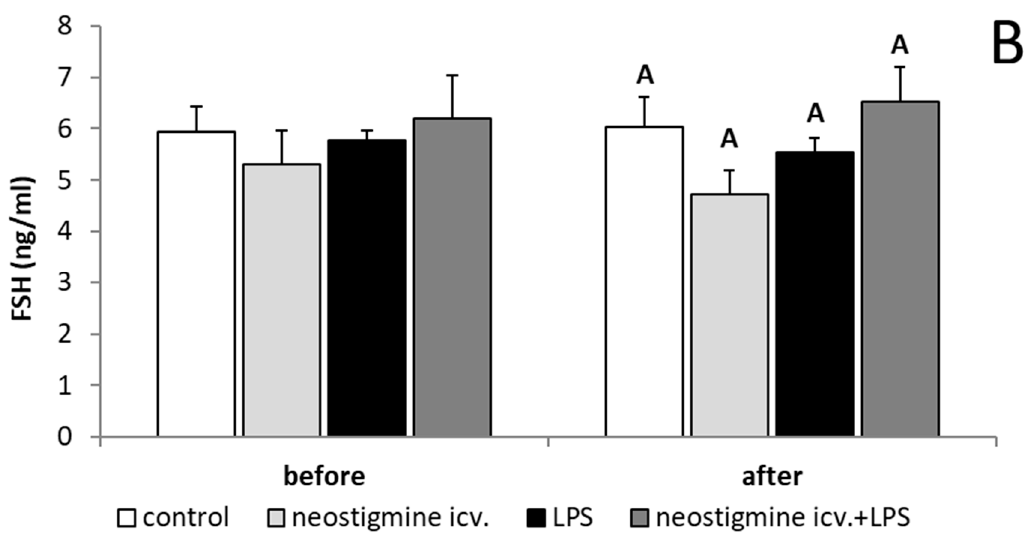
Figure 1. Effect of lipopolysaccharide (LPS; 400 ng/kg; intravenous) and neostigmine (1 mg/animal; intracerebroventricular (icv.)) injections on plasma concentration of luteinizing hormone (LH) ( A ) and follicle-stimulating hormone (FSH) ( B ) concentrations in the blood plasma. The data are presented as the mean value ± S.E.M. ( n = 6 animals per group). All experiments were divided into two periods: a baseline with no treatment (2 to 0.5 h before) and the one after treatment (1 to 3 h after). *—asterisk indicates statistically significant differences between the baseline period and the period after treatment found during a Student’s t -test for dependent samples (“repeated measures”). A two-way ANOVA was used to analyze the concentrations of plasma hormones obtained only after treatment. Significant differences marked with different capital letters were analyzed by a two-way ANOVA followed by a Fisher’s post hoc test. Statistical significance was stated when p < 0.05.